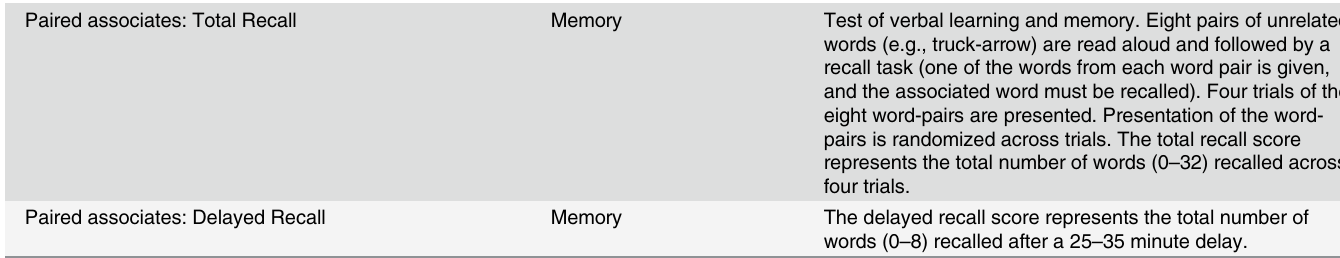
recall task (one of the words from each word pair is given, and the associated word must be recalled). Four trials of the eight word-pairs are presented. Presentation of the word- pairs is randomized across trials. The total recall score represents the total number of words (0 – 32) recalled across four